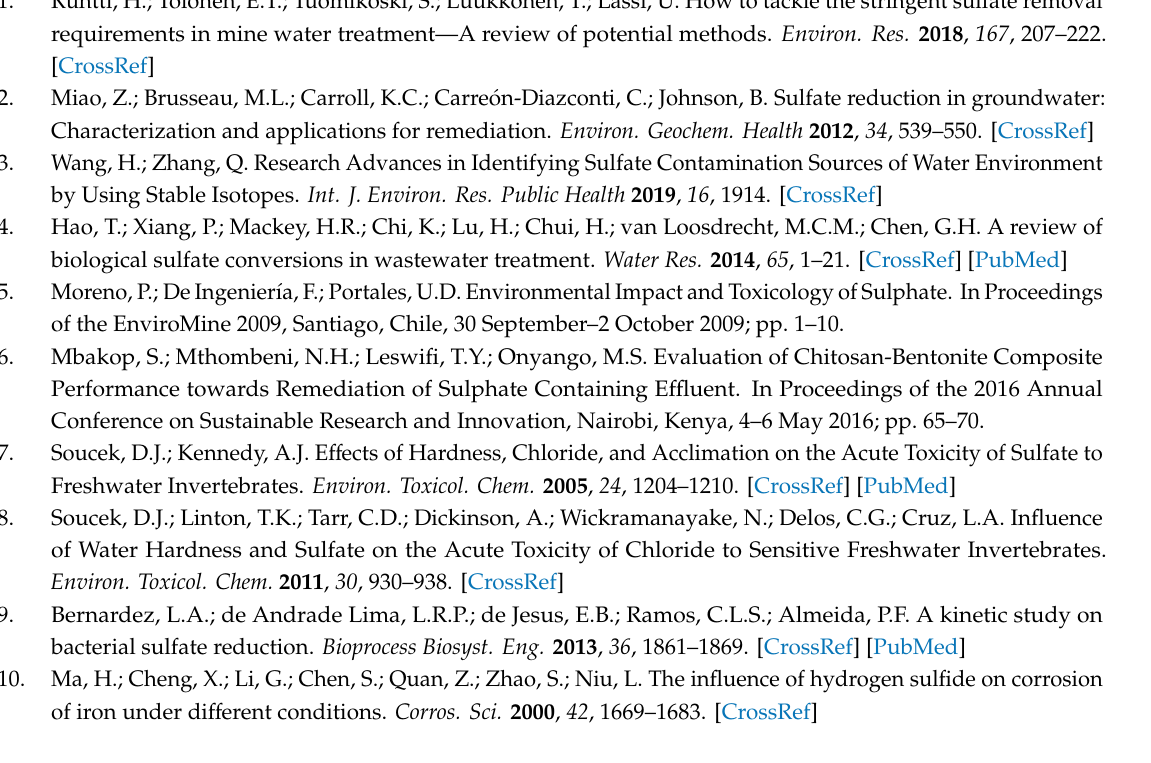
Table S1: Chemical analysis report of Well-1 sample, Table S2: Chemical analysis report of Well-2 sample, Table S3: Chemical analysis report of Well-3 sample, Table S4: Sips isotherm adsorption parameters for sulfate dianion species at 298 K and pH 6.8 in aqueous solution, Table S5: Measured (ICP-OES) copper concentration in well water samples and various composite materials (chitosan powder (C), chitosan pellet (CP), CAAl (chitosan-alginate-aluminium) and two CPCu (chitosan pellet; copper) as well as two CACu (chitosan, alginate, copper) materials) to assess potential health hazards from copper leaching of the polyelectrolyte composite materials and comparison to C-BMS, where copper was replaced with aluminum to compare it with the copper containing materials concerning leaching, Figure S1: DSC thermograms of composite materials ( a ) CCu, ( b ) CACu1, ( c ) CACu2 and ( d ) CACu3, Figure S2: Derivative plot from TGA for C, A, CCu, CACu1, CACu2, and CACu3, Figure S3: XRD patterns of C, A, CACu1, CACU2, CACu3 and CCu, Figure S4: PZC graph for C, A, CCu and CACu1-3 materials, Figure S5: XPS wide scan spectra of CACu1 after the adsorption